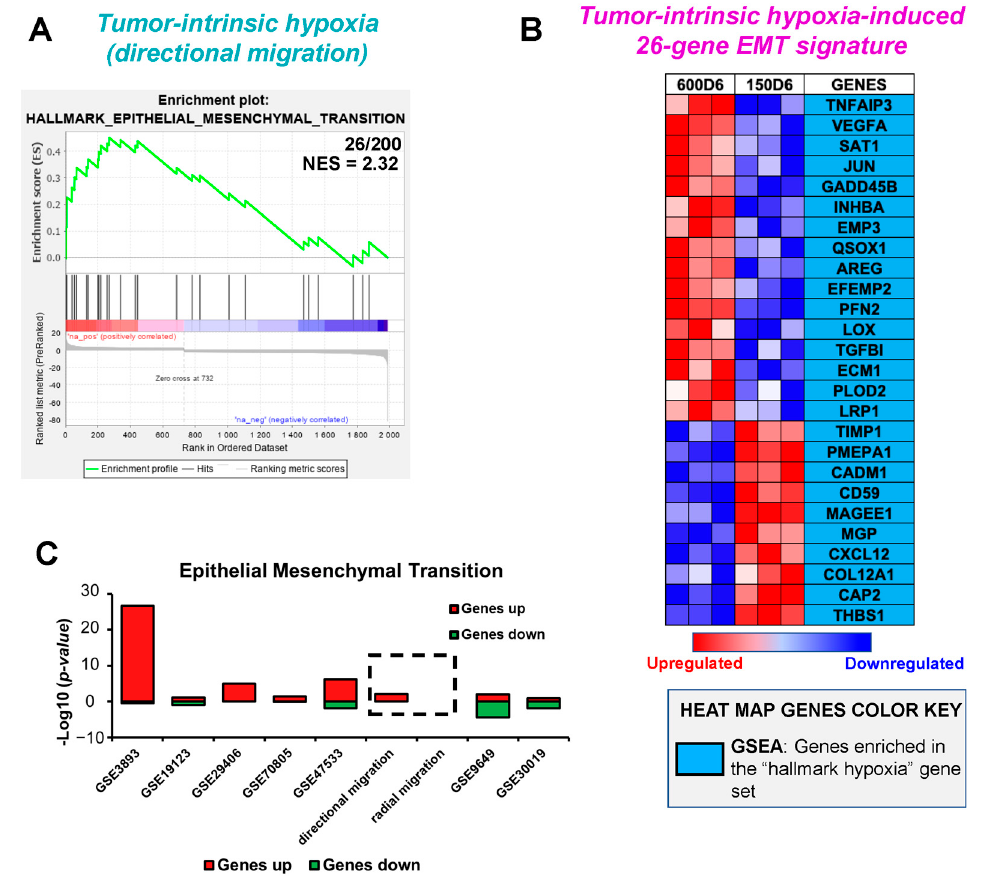
Figure 4. Epithelial to mesenchymal transition is enriched in hypoxia-induced directional migration compared to secretome-induced radial migration. ( A ) GSEA enrichment plot of DEGs showing 26 genes enriched in tumor-intrinsic hypoxia-induced directional migration out of 200 in ’Hallmark Epithelial Mesenchymal Transition’ and a Normalized Enrichment Score (NES) of 2.32. ( B ) Correlation engine meta-analysis, comparing the significance of overlap with the GO term ’Epithelial Mesenchymal Transition’ of hypoxia-induced directional migration, and seven publicly available genomic studies (GSE3893, GSE19123, GSE29406, GSE70805, GSE47533, GSE9649, GSE30019). ( C ) Heat map of tumor-intrinsic hypoxia 26-gene signature set that compiles genes in ‘Hallmark Epithelial Mesenchymal Transition’ common to the DEGs in the directional migration.